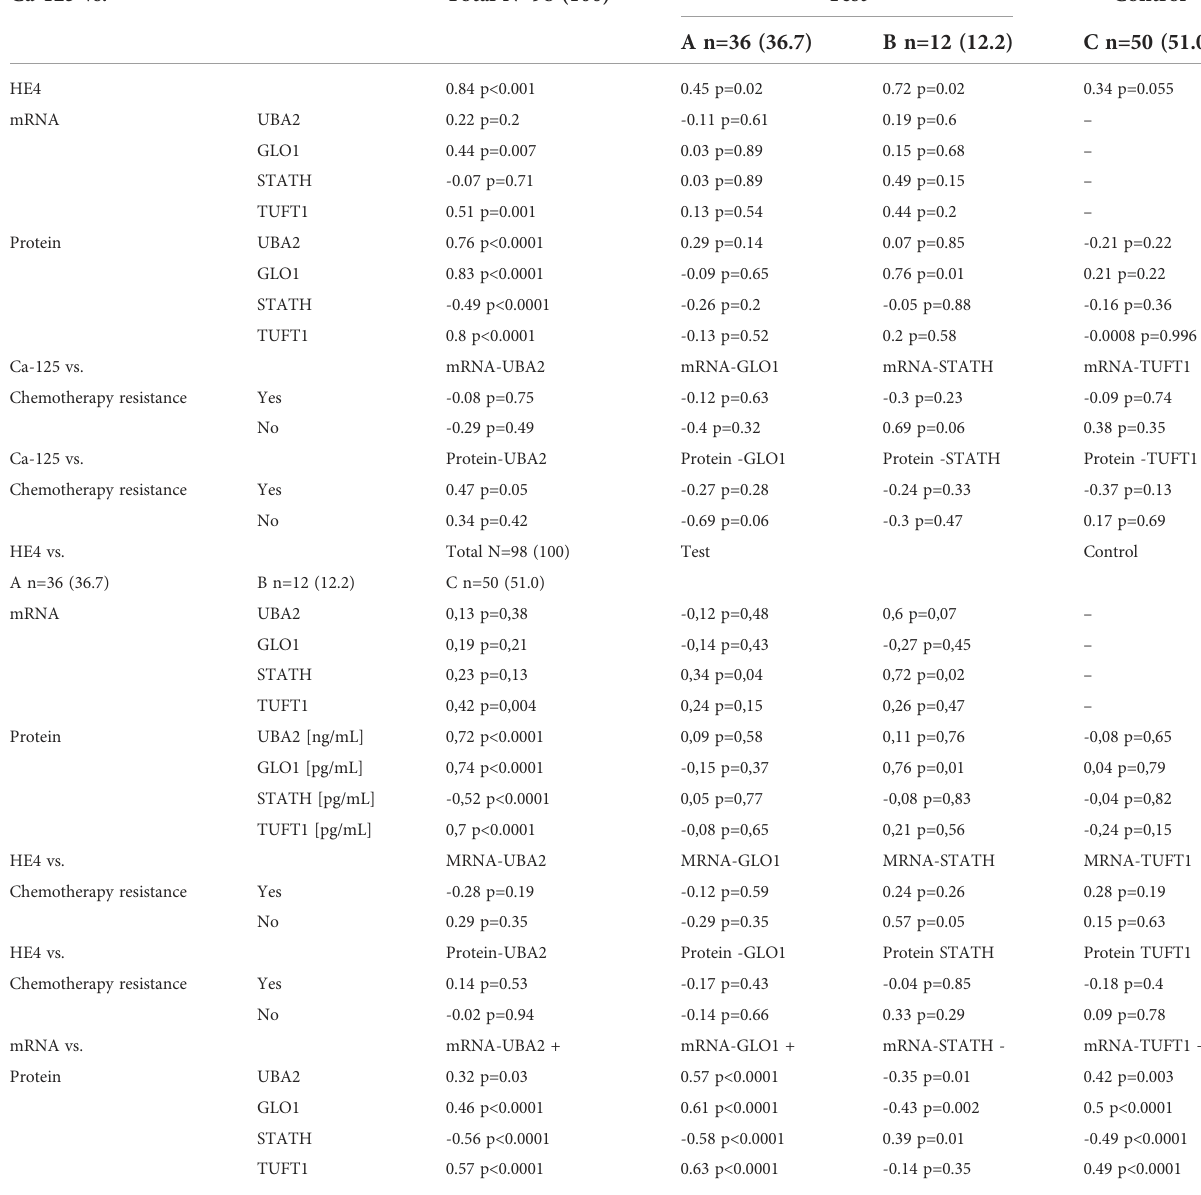
TABLE 7 Correlation between levels of biochemical and molecular markers, as values of Spearman ’ s R coef fi cients and the signi fi cance p -value, among women with ovarian cancer (groups A and B) compared with those of women in the control group (C). Ca-125